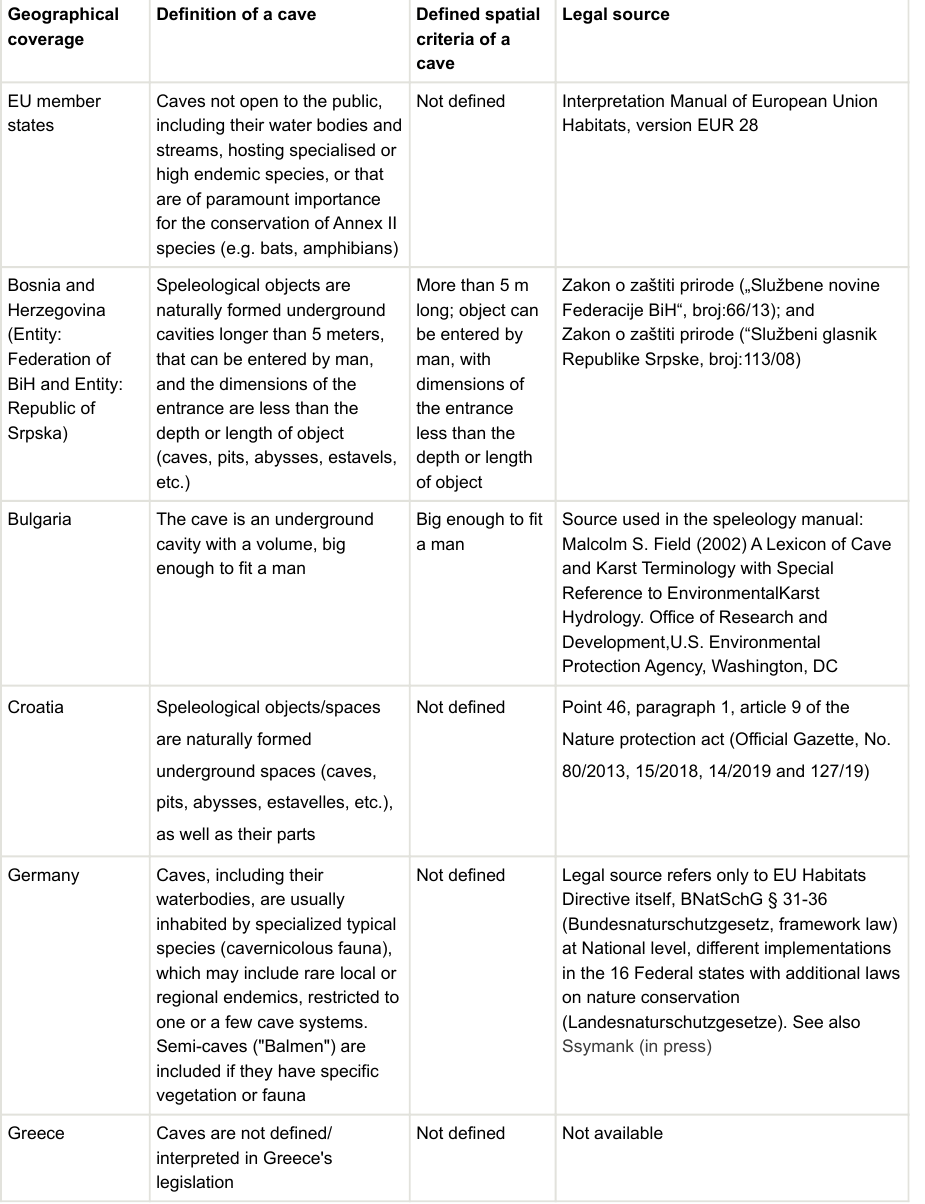
Table 1. List of selected legal definitions of "a cave" for monitoring purposes.